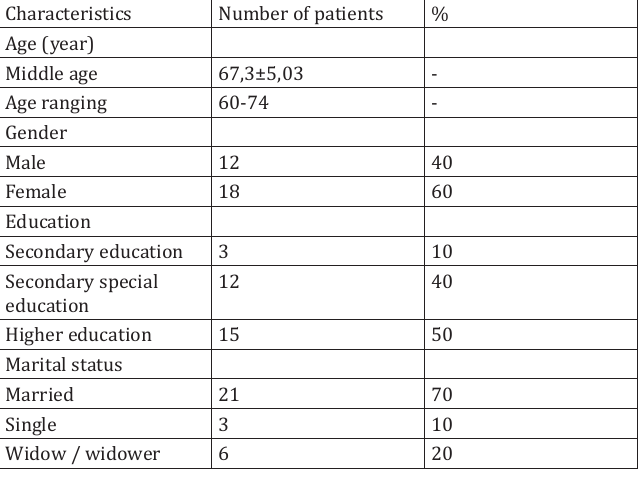
Socio-demographic characteristics of respondents (n=30)